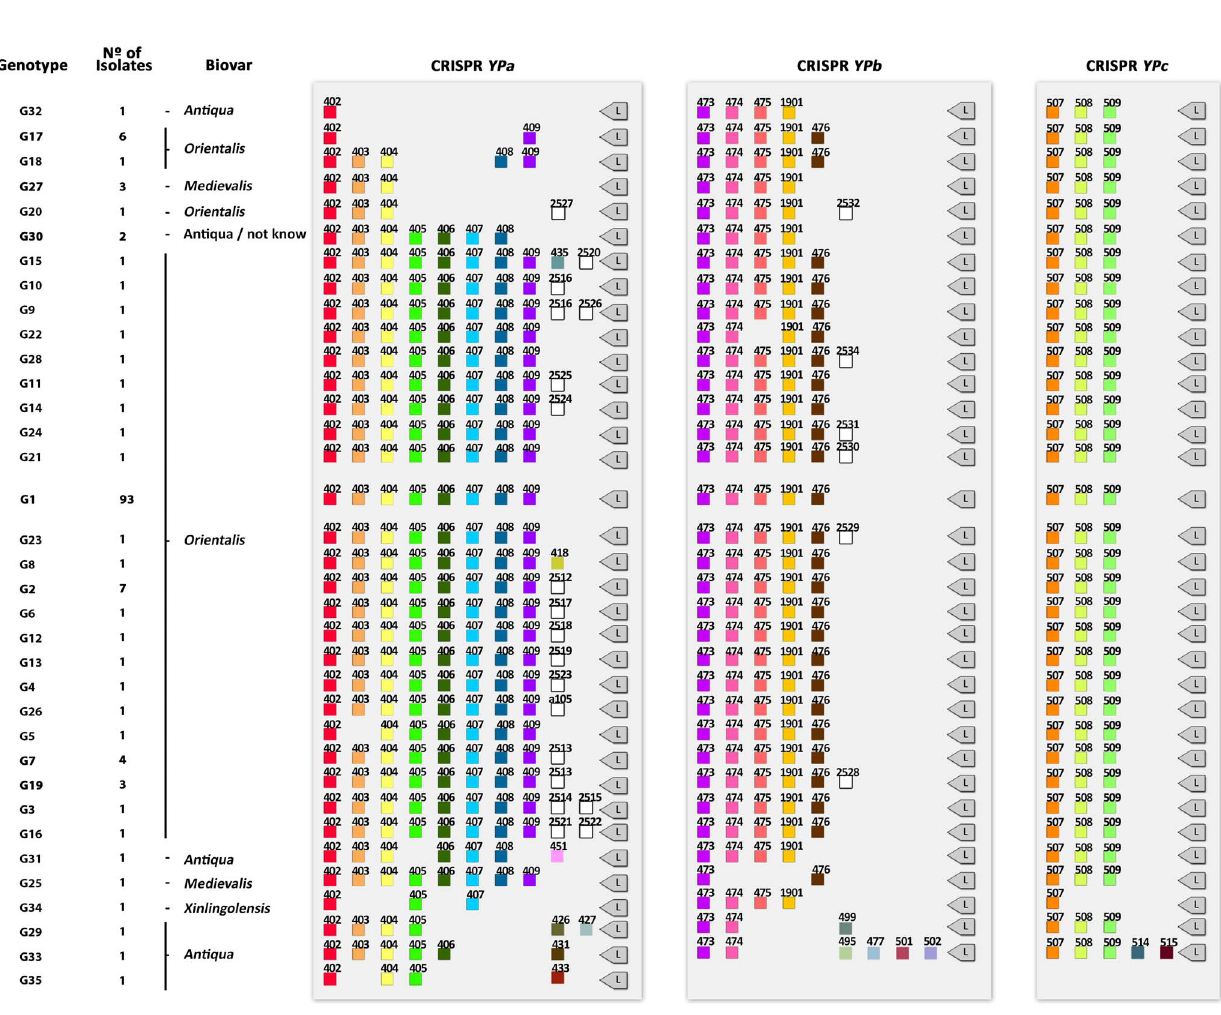
Figure 1. Groups of Y.pestis strains in accordance with the CRISPR spacer array of the three loci. Representation of spacer arrays distributed among the total number of identified genotypes: Colored boxes, spacers previously described [3], [4], [5]. White boxes, new spacers. L: leader sequence.